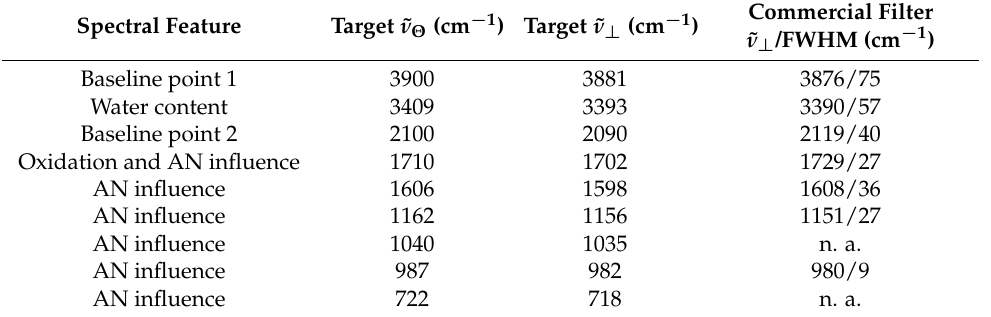
Table 2. Overview of the oil condition parameters to be monitored and the corresponding optical bandpass filters selected for the implementation of the NDIR sensor. FWHM: full width at half maximum.